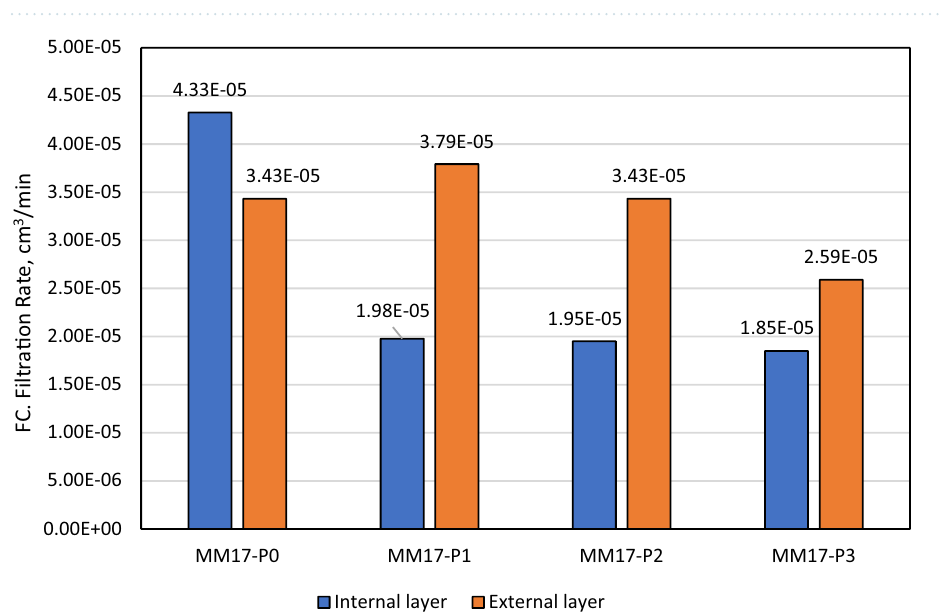
Figure 3. Filtration behavior as function of perlite concentration for samples with mud density equal to 17.2 ppg.